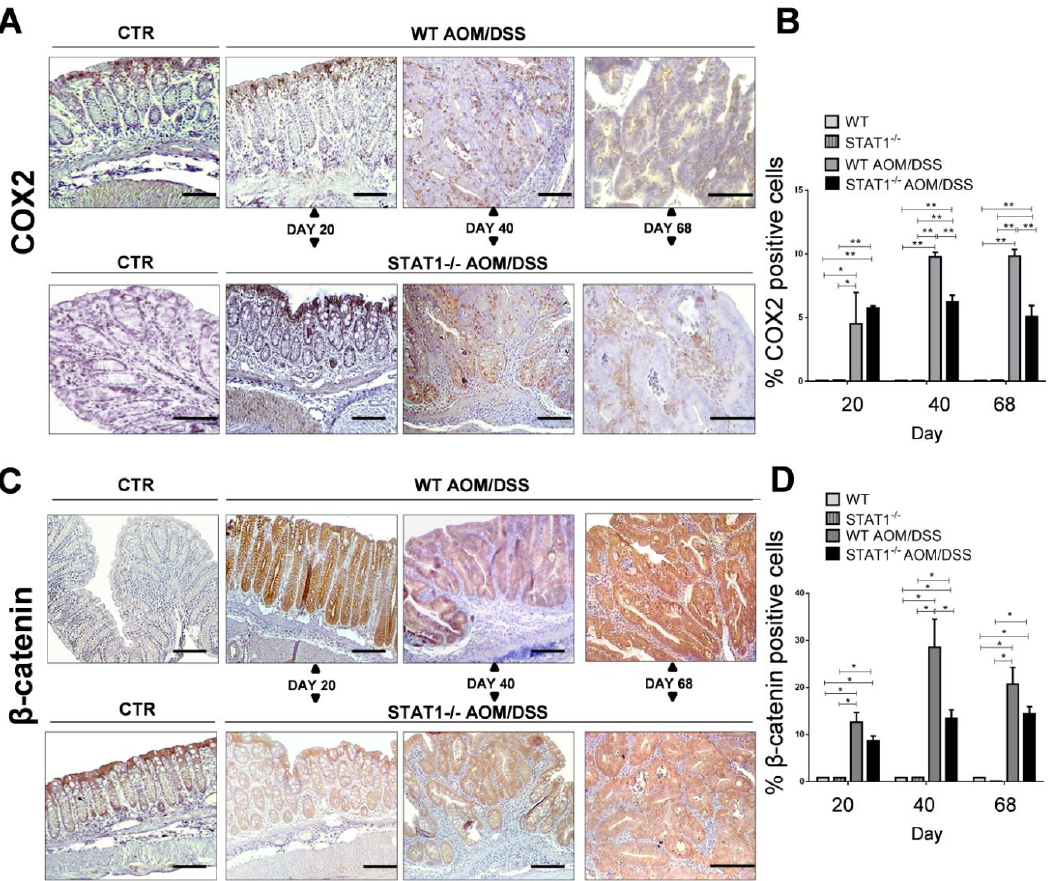
Figure 4. Immunohistochemical detection of COX-2 and β -catenin in colon tissue. Distal/affected colons were obtained from WT and STAT1 − / − AOM/DSS-treated or control mice at the indicated time intervals. ( A ) Immunostaining for cyclooxygenase-2 enzyme (COX-2) in the colons of control and treated groups. ( B ) Average percentages of COX-2 + cells in distal colon samples are indicated in the bar graph. ( C ) Immunostaining for β -catenin. ( D ) Average percentages of β -catenin+ cells in the colon (scale bars, 50 µm). Quantification of COX2 + and β -catenin + cells was performed using ImageJ